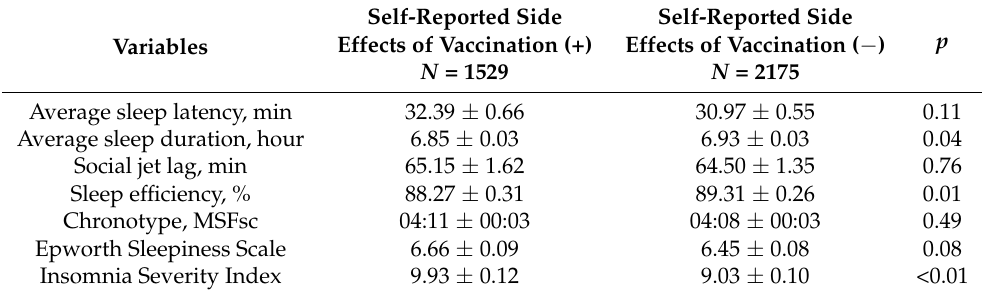
Table 5. Sleep and circadian rhythms according to self-reported side effects of COVID-19